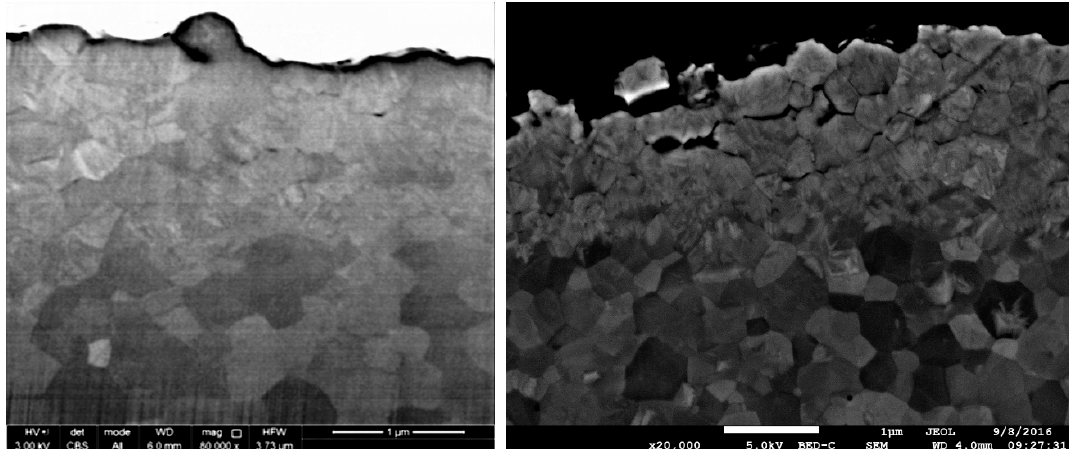
Figure 5. Scanning Electron Microscopy (SEM) images showing a transformed layer after ageing for 60 days in water set at 85 °C (left: FIB section, right: cross-section).